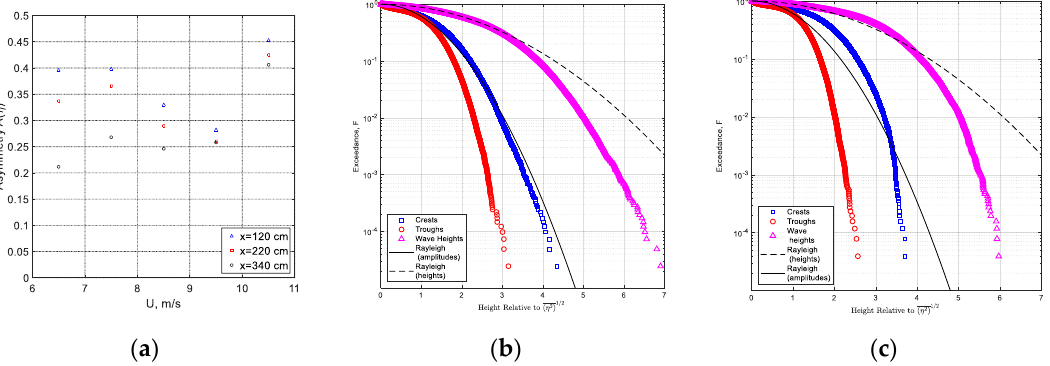
Figure 10. Characterization of wave shape asymmetry: ( a ) Asymmetry A ( η ) of the surface elevation; ( b ) exceedance distributions of crest heights ( η c ), trough depths ( η t ), and crest-to-trough heights ( h ) at x = 220 cm, U = 8.5 m/s; ( c ) as in ( b ) for x = 340 cm, U = 10.5 m/s.